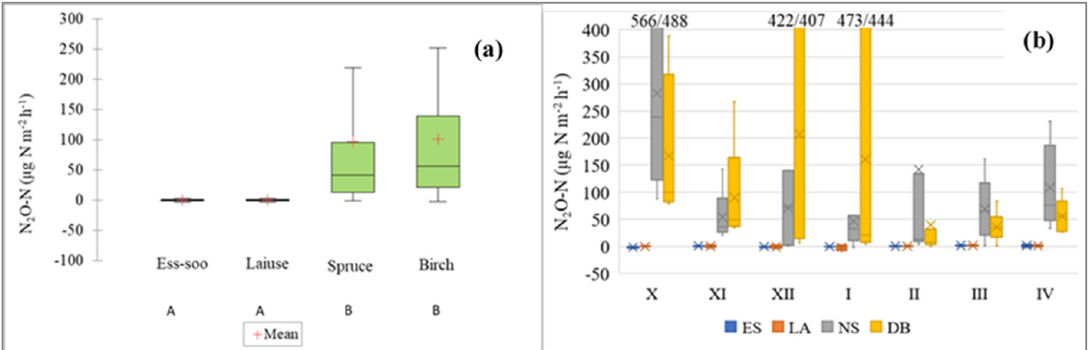
Figure 8. ( a ) N 2 O-N emissions from abandoned peat extraction areas (Ess-soo (ES) (n = 25) and Laiuse (LA) (n = 25)) and drained peatland forests (Norway spruce (NS) (n = 41) and Downy birch (DB) (n = 41)). A and B—significantly differing values (Kruskal–Wallis ANOVA test and multiple comparison of mean ranks test). ( b ) Cold period N 2 O emissions; X (October) to IV (April)—months. In both figures, the median, 25 and 75% quartile and min / max values are shown.